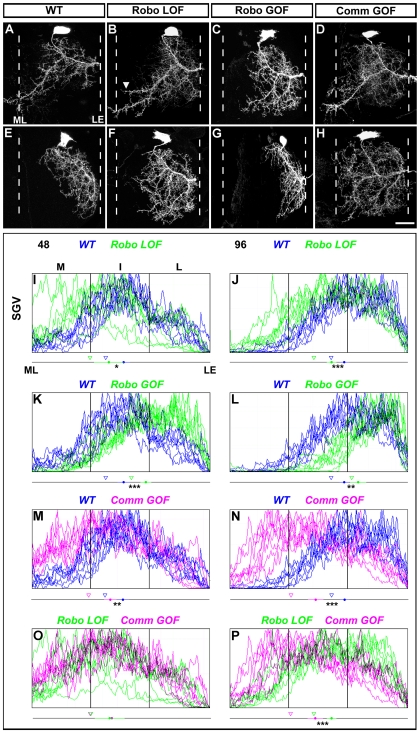
Slit-Robo signalling mediates dendritic targeting of motoneurons within the medio-lateral axis of the leg neuropil.(A) Motoneurons born following heatshocks at 48 h AH elaborate dendrites across all three neuropil territories and send a large posterior branch toward the midline. (B) Robo null clone generated at 48 h AH generates ectopic dendritic projections near the midline at the posterior region of the neuropil (arrowhead). (C) Robo gain of function clones generated at 48 h AH lack the midline crossing event in the posterior region of the neuropil. (D) Misexpression of Comm in motoneurons generated at 48 h AH clones results in inappropriate growth of dendrites towards medial regions of the neuropil. (E) Motoneurons born following a heatshock at 96 h AH elaborate dendrites in intermediate and lateral territories within the leg neuropil. (F) Robo null clones generated at 96 h AH show medial shifts in the distribution of their dendrites. (G) Misexpression of Robo in 96 h AH clones results in dendrites being shifted away from the midline into very lateral neuropil territories. (H) Misexpression of Comm in the 96 h AH clones results in dendrites that span the medio-lateral axis of the neuropil. (I–P) Plot profile graphs to reveal the distribution of dendrites along the medio-lateral axis within the leg neuropil (n = 8 for each genotype). The mean centre of arbor mass (circle) for the dendritic arbors and the standard error of each experimental condition and the statistical significance between groups are also shown. Triangles denote the 33rd percentile for each group. Scale bar = 20 µm. * p<0.05, ** p<0.01, and *** p<0.001.